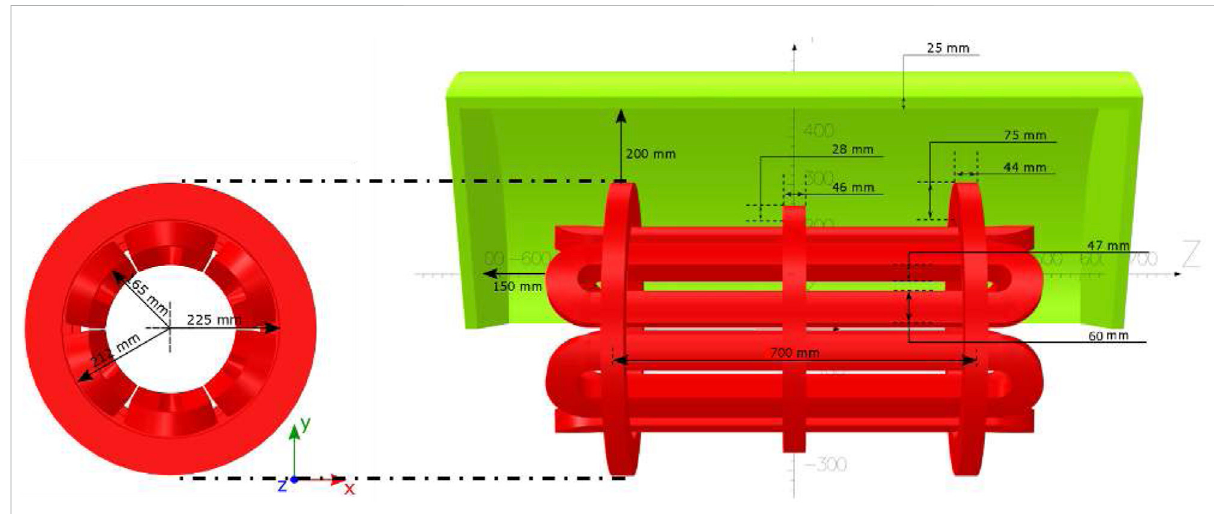
FIGURE 1 Viewofthemagneticsystemcon fi gurationwithitsfundamentalsimulateddimensions.Greenelementrepresentstheironyoke(1/3symmetry).